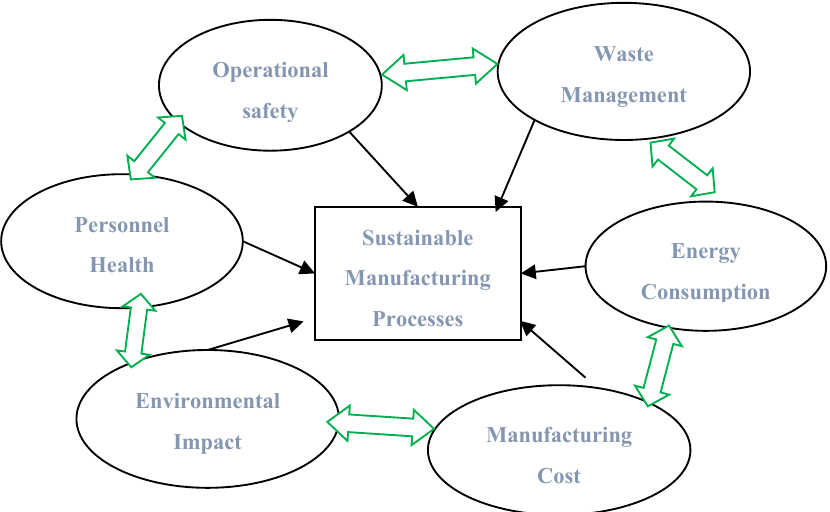
Figure 1. Six Elements of Sustainable Manufacturing Processes.